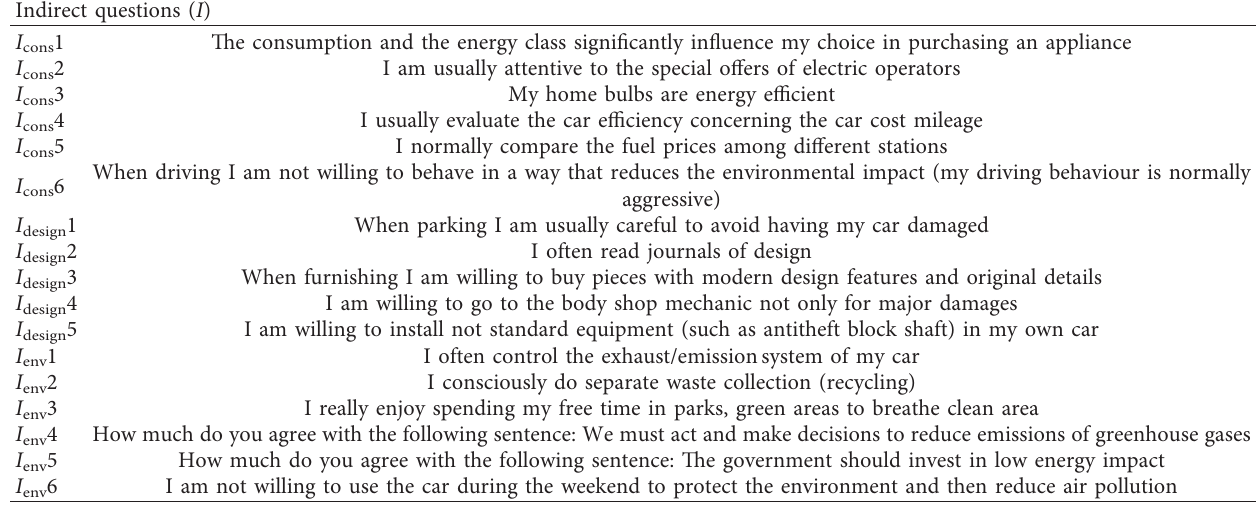
Table 3: Overview of indirect questions submitted to the